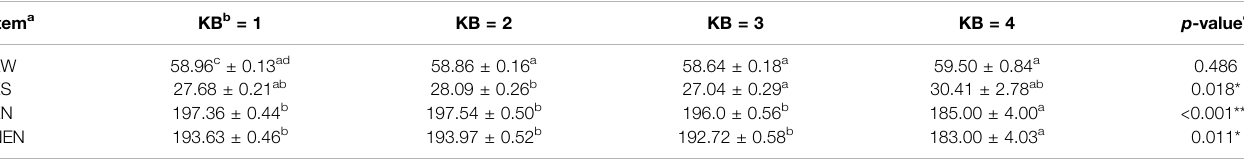
TABLE 3 | Production performances of laying hens at different KB levels.